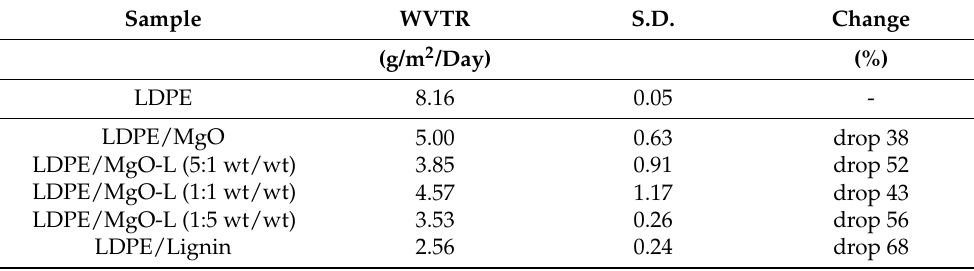
Table 4. Water vapor transmission rate (WVTR) of neat LDPE film and composite